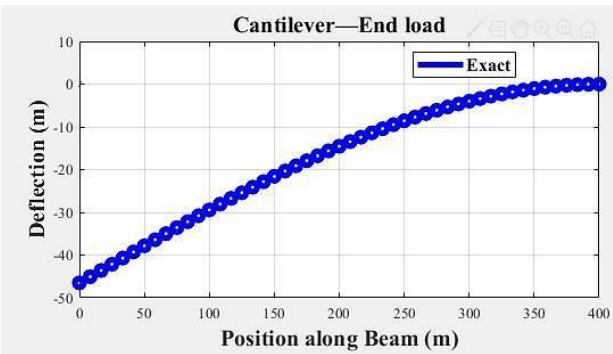
Fig. 7. Total deformation of -46.509 mm (max.) of cemented carbide, simply supported beam with load at the midpoint of the span